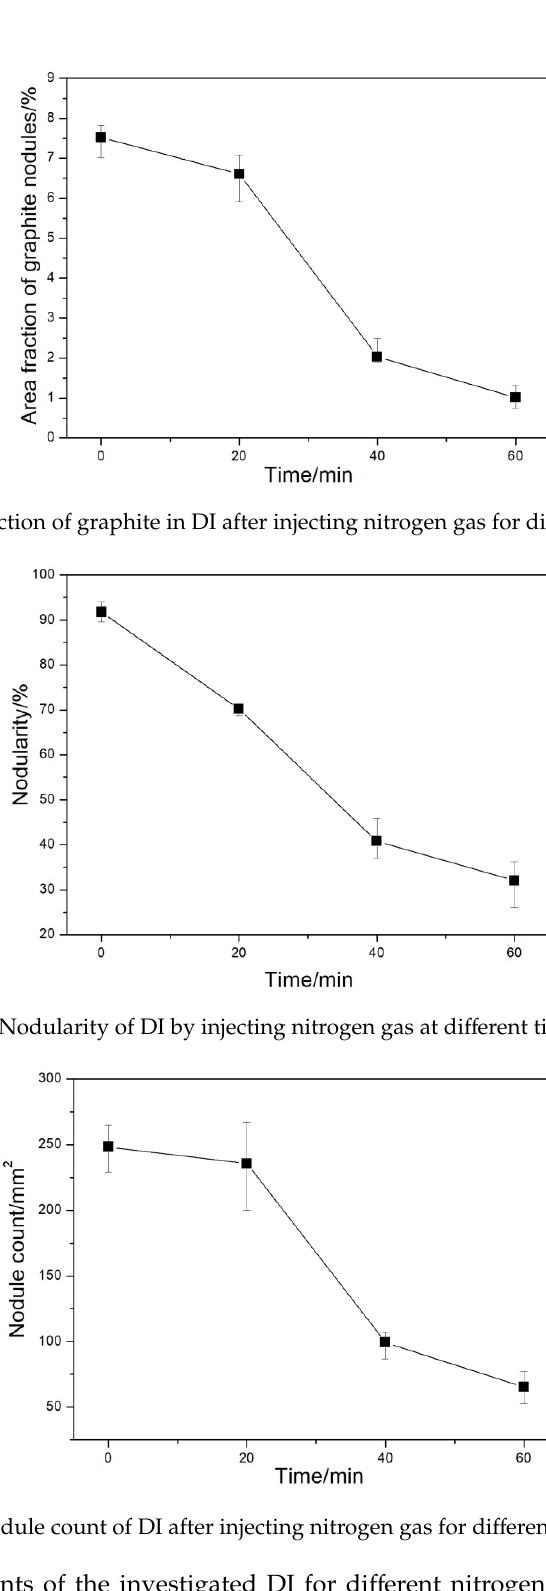
Figure 6. Nodule count of DI after injecting nitrogen gas for different time periods. Table 1. Chemical compositions of DI after injecting nitrogen gas for different time periods. Time